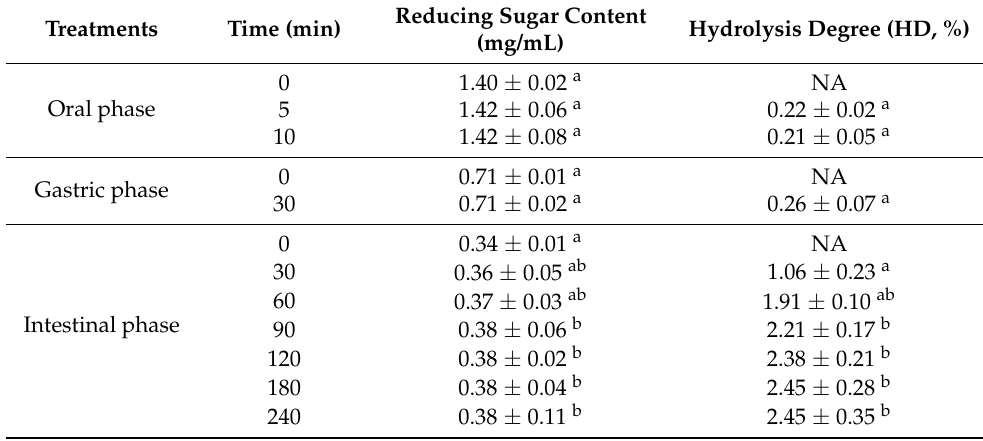
Table 1. Reducing sugar content and hydrolysis degree of IMOs during the oral, gastric and intesti- nal phases of digestion.